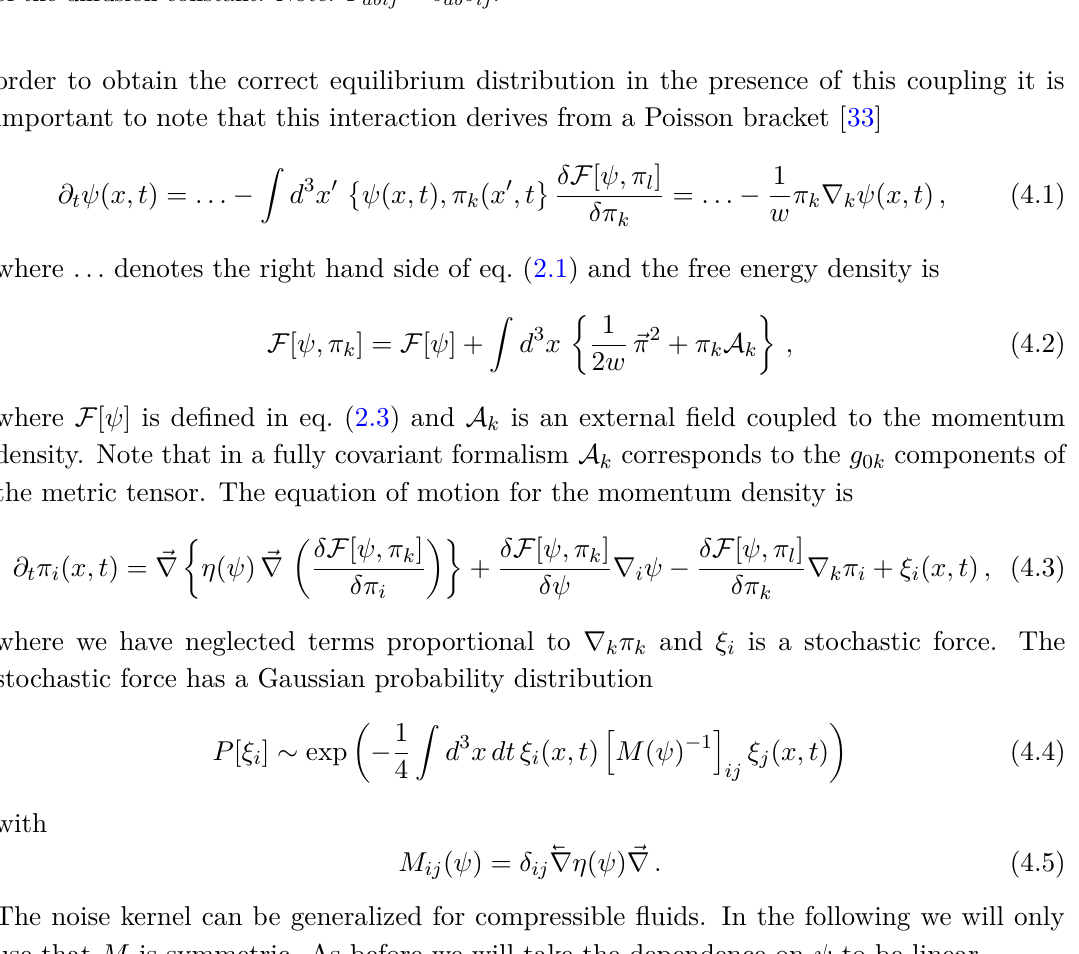
Figure 3. Feynman rules for model H, describing the interaction of the transverse momentum density π k with a scalar density ψ . The vertex denoted by the solid circle is a non-linear interaction term, and the vertex denoted by a solid square is a new interaction generated by the field dependence of the diffusion constant. Note: P abij = δ ab δ ij